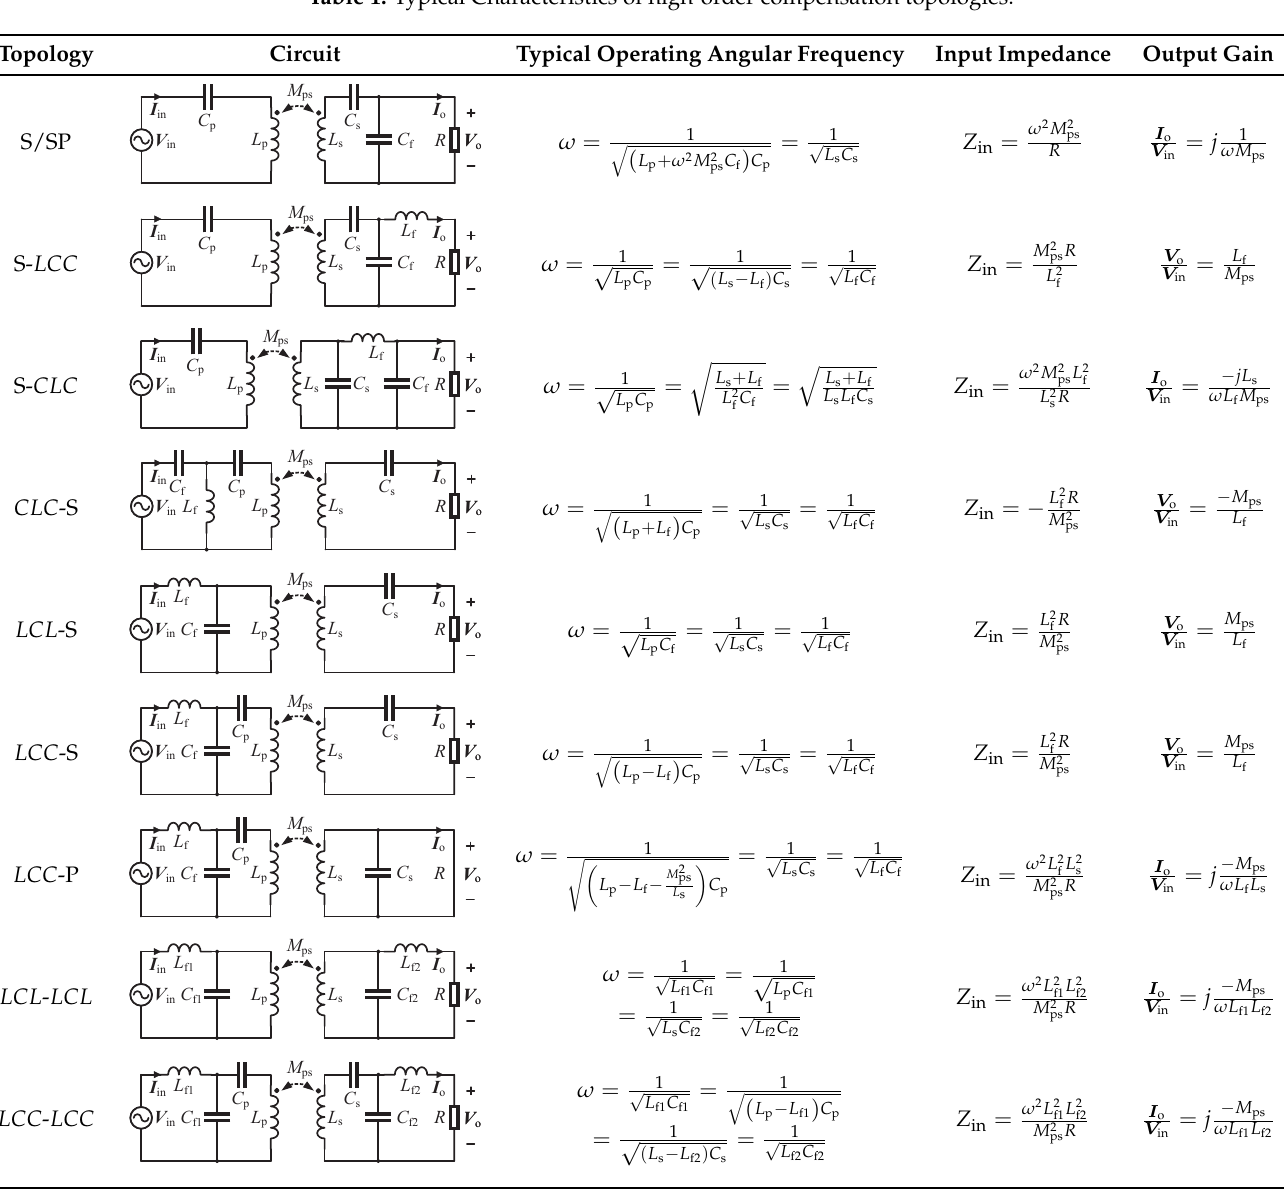
Table 1. Typical Characteristics of high-order compensation